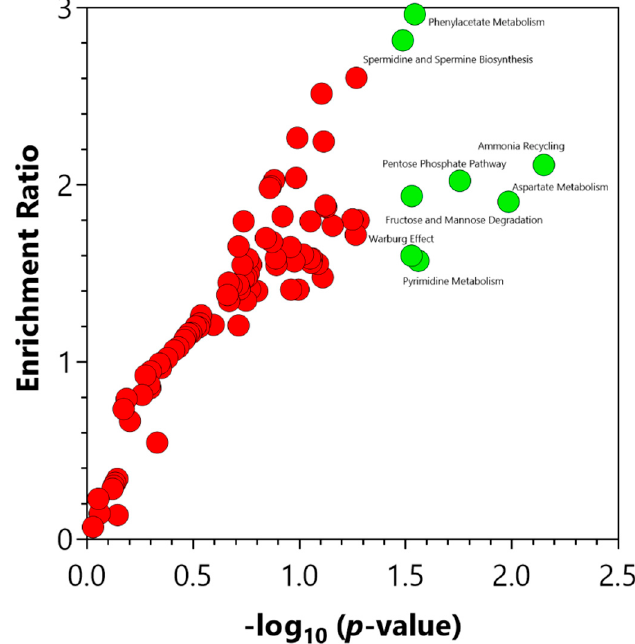
Figure 4. Significant pathways identified via the enrichment analysis of the central carbon metabolism intermediates using MetaboAnalyst 5.0 (Enrichment Analysis Toolbox, Quebec, Canada). Pathways annotated with red circles were enriched but found not to be significant. Pathways annotated with green circles were significantly ( p -value ≤ 0.05) enriched. The significantly enriched pathways are illustrated in Supplementary Table S4.